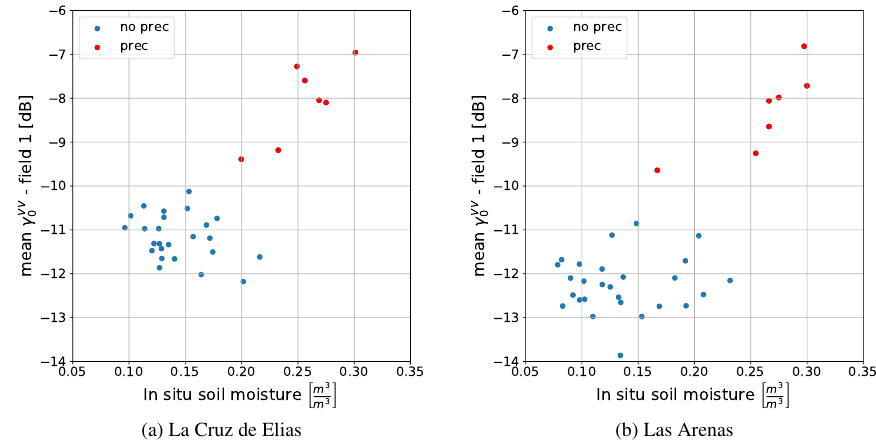
Figure 7. Comparison between superficial soil moisture in m 3 /m 3 and γ V V 0 in dB for the field 1 of 7a) La Cruz de Elias and 7b) Las Arenas, with highlighted in red the dates corresponding to precipitation events.